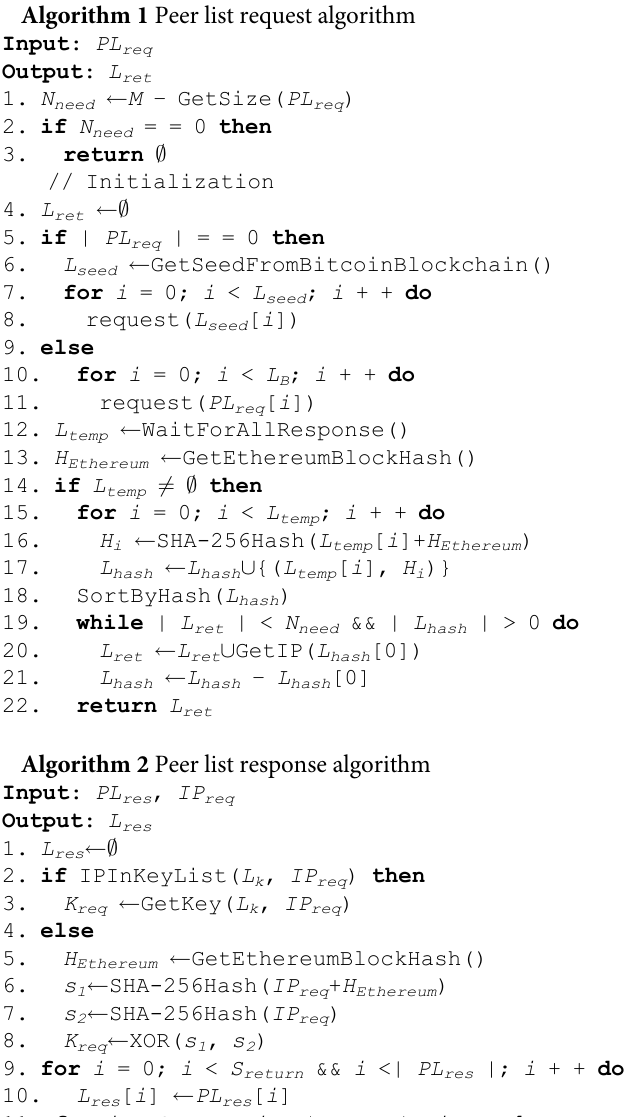
Algorithm 1 Peer list request algorithm